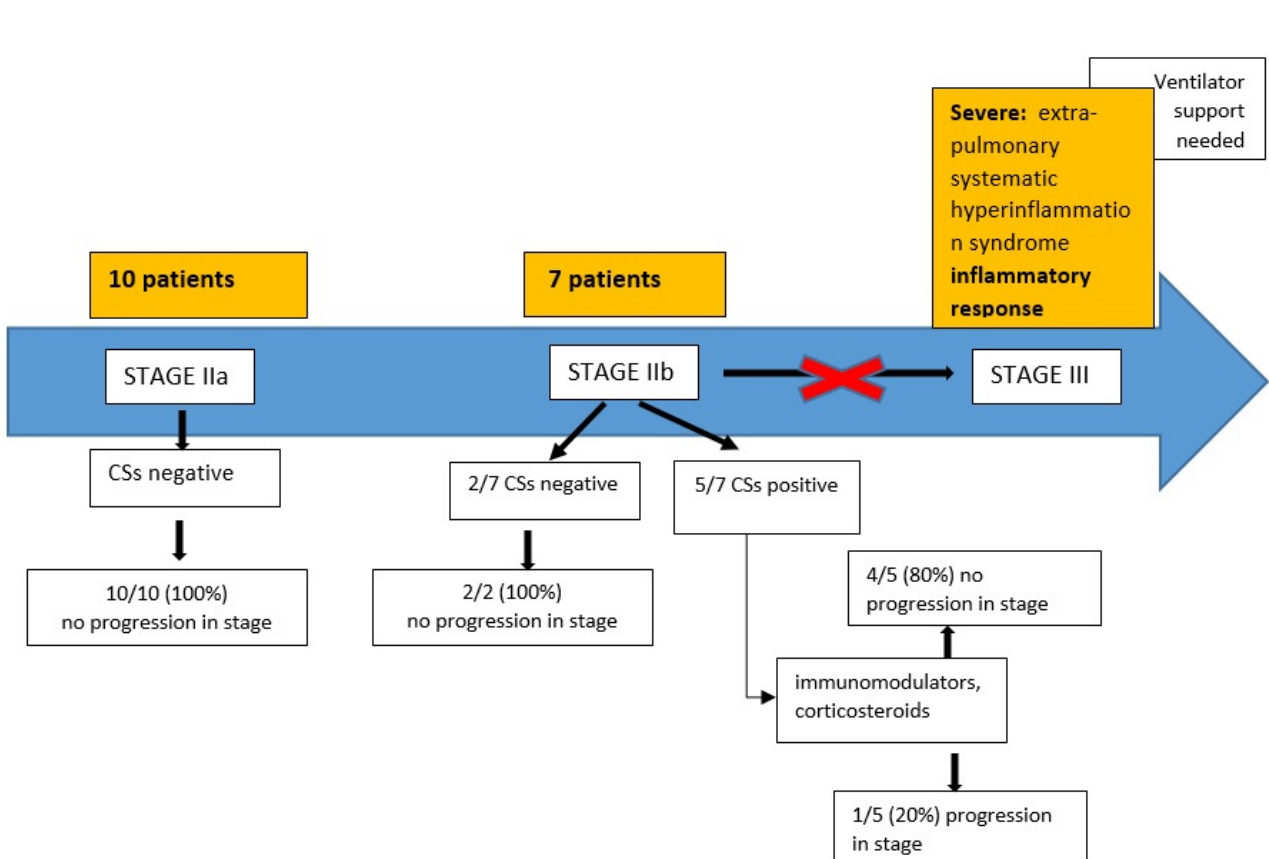
Figure 3. Patients admitted to Infectious Diseases Department with confirmed SARS-CoV-2 infection between April 15 and August 31.